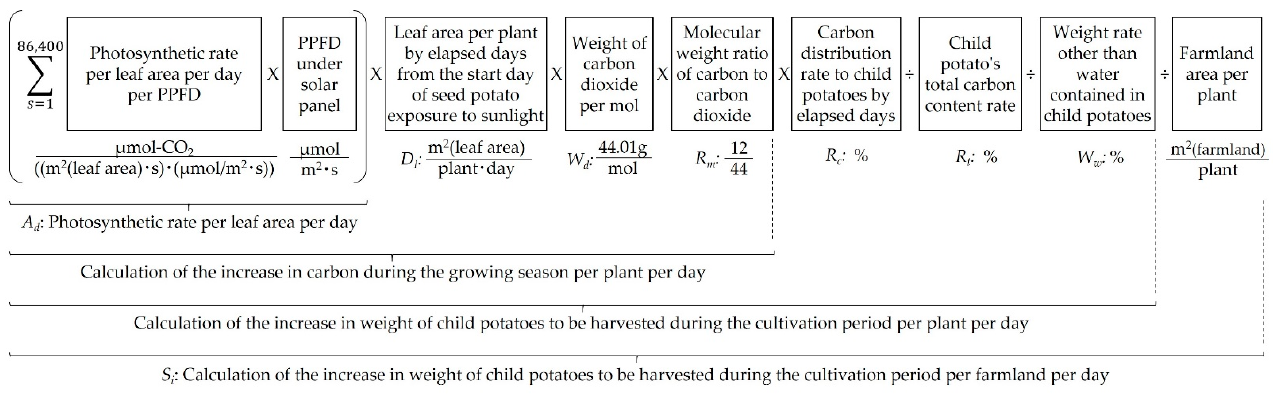
Figure 3. Schema of the equation.